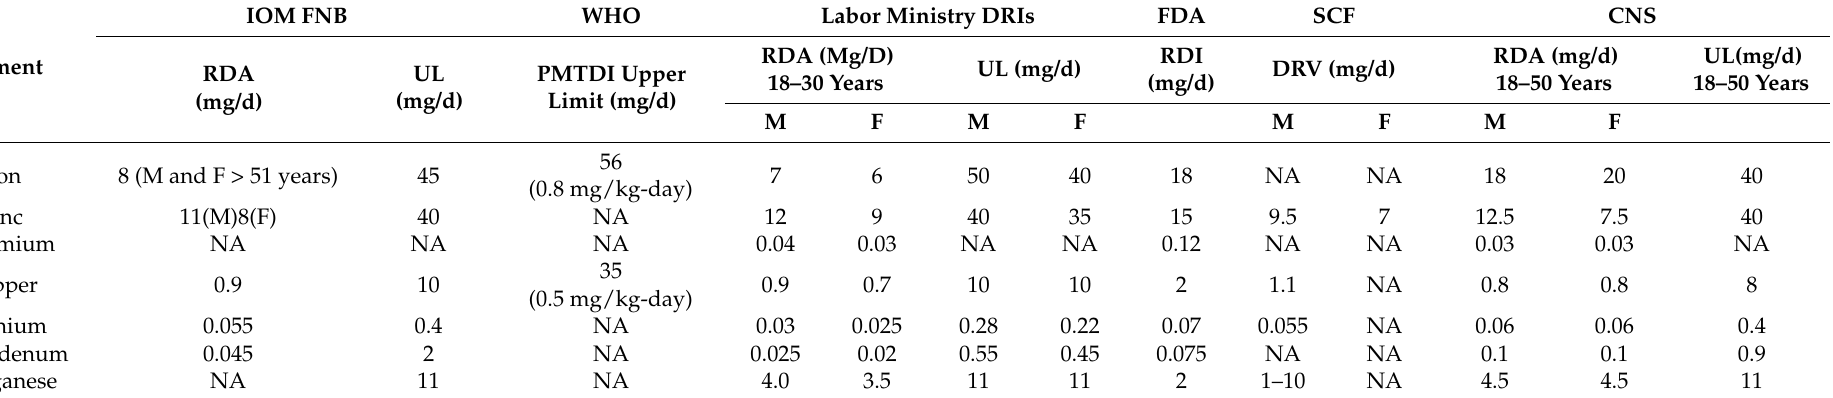
Table 1. Summary of essentiality and toxicity data for metal trace